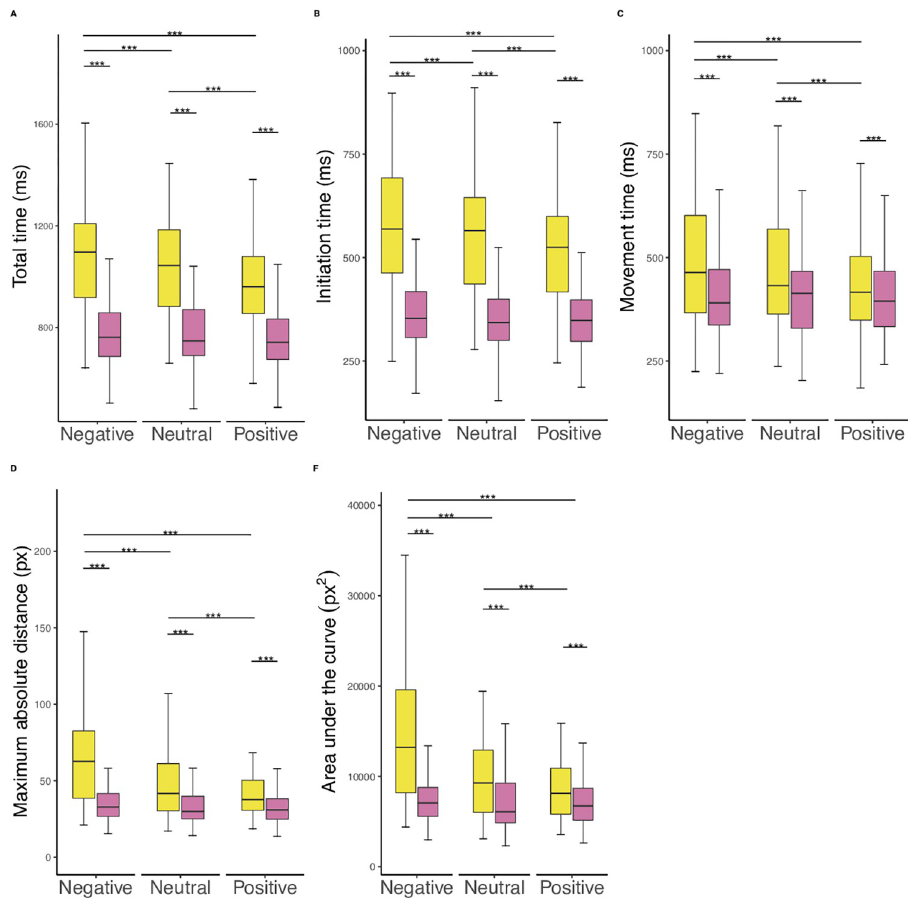
Fig 2. Reaction times and mouse trajectories across interindividual differences in rule-breaking and type of consequences when following the rule. Yellow = rule-breakers, Pink = rule-followers. Significance: ��� = p < .001. The top and bottom whiskers are set to the highest/lowest value of the dataset that are included in the 1.5IQR range.